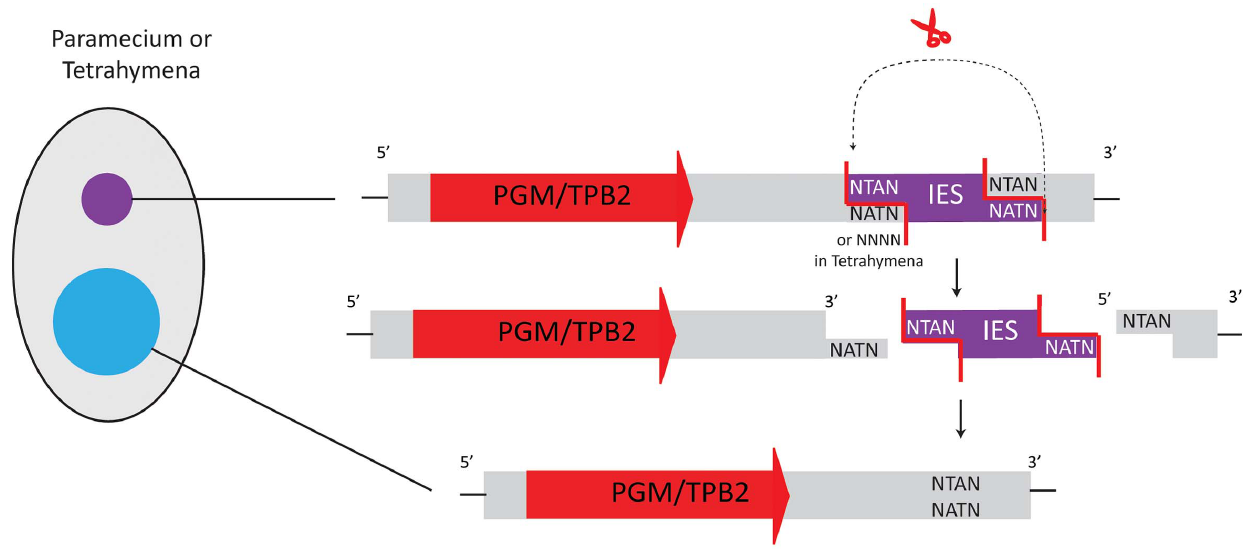
Figure 3. Transposases in Tetrahymena and Paramecium belong to the PiggyBac family. As domesticated transposases, they are present as single-copy genes in the micronuclear and macronuclear genomes. After expression from the somatic genome, they facilitate IES excision from the new macronuclear genome. IES removal occurs via a 4-base 5 9 protruding end. In Paramecium, all deleted sequences have a TA dinucleotide at both boundaries, whereas Tetrahymena displays no consensus sequence.